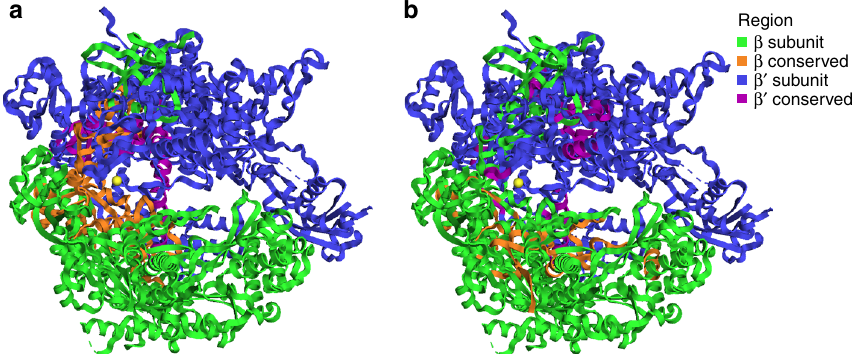
Fig. 4 Conserved regions visualized in yeast RNAP protein structure. Image of RNAP β (RPB2 subunit in eukaryotes) and RNAP β ′ (RPB1 subunit in eukaryotes) subunit structures of S. cerevisiae (PDBid: 2e2i) 24 . Colors correspond to subunit and conserved regions. a Regions conserved across all examined taxonomic groups (Supplementary Dataset 3) when amino acid sequences of β and β ′ are aligned separately. b Regions conserved between β and β ′ across all examined taxonomic groups when β and β ′ are aligned to each other (Supplementary Dataset 3).